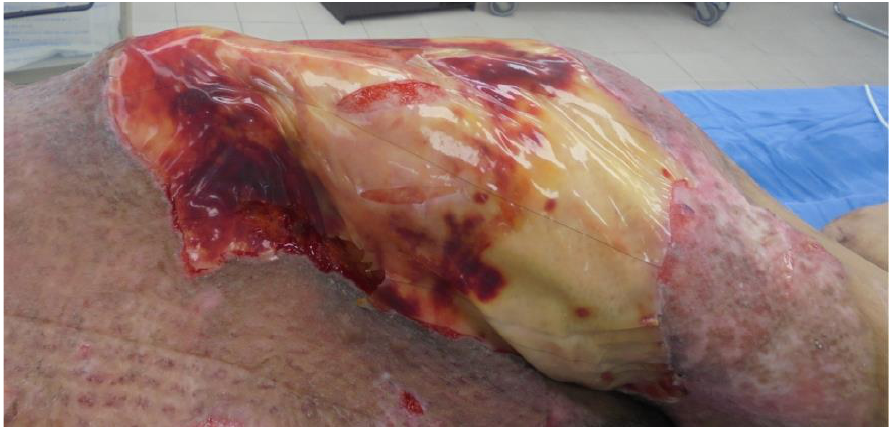
Figure 2. Integra applied on burn wound .